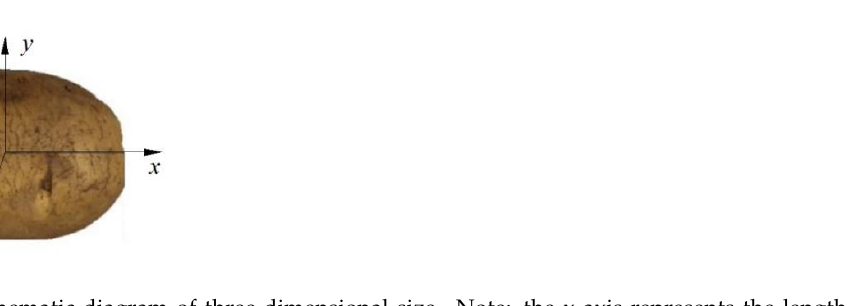
Figure 1. Schematic diagram of three-dimensional size. Note: the x axis represents the length direction, the y axis represents the height direction, and the z axis represents the width direction.